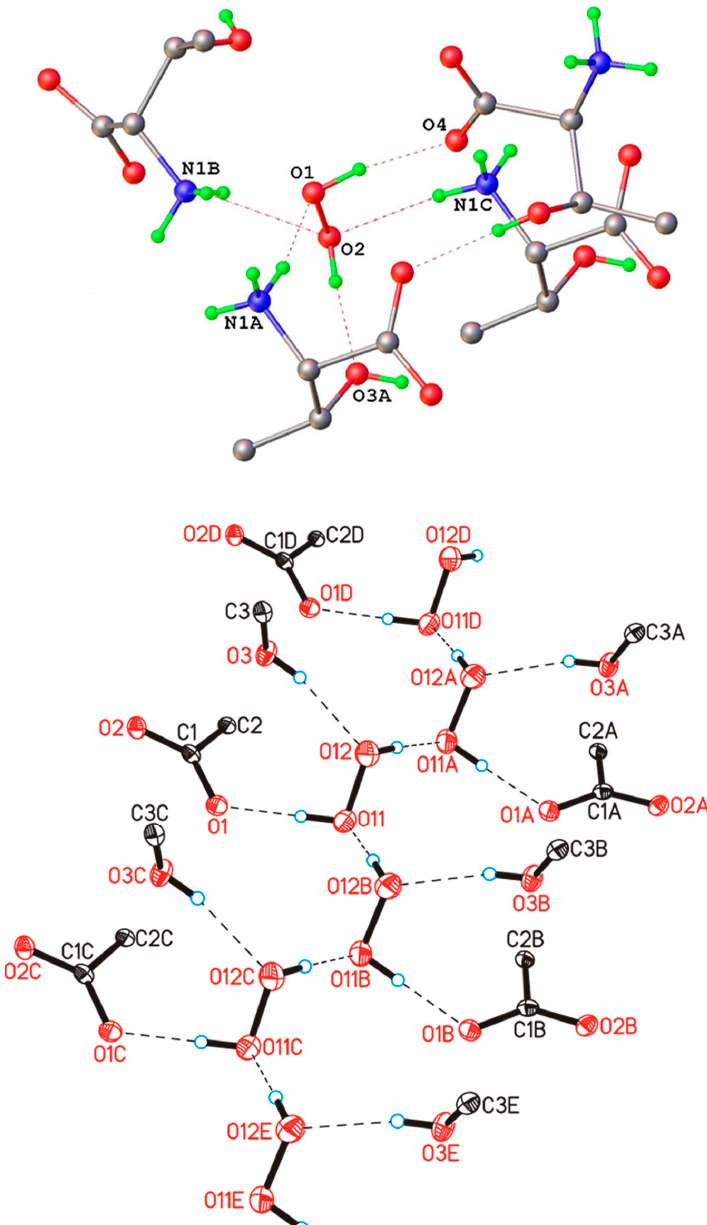
Figure 10. H-bond networks in amino acid peroxosolvates. Upper panel: L -threonine peroxosolvate: three H-bonds between the H 2 O 2 molecule and the NH 3+ groups. (Reproduced from the work in [95] with permission from The Royal Society of Chemistry) Lower panel: phenylserine peroxosolvate: no H-bonds between the H 2 O 2 molecule and the NH 3+ groups. The phenyl and amino groups of phenylserine are omitted. (Reproduced from the work in [96] with permission from The Royal Society of Chemistry). H-bonds are shown with dashed lines. Table 2. H-bonds of H 2 O 2 molecules as proton acceptors in crystalline peroxosolvates of amino acids and non-proteinogenic amino acids [95]: the number of H-bonds formed by one H 2 O 2 molecule and nature of the proton donor group.